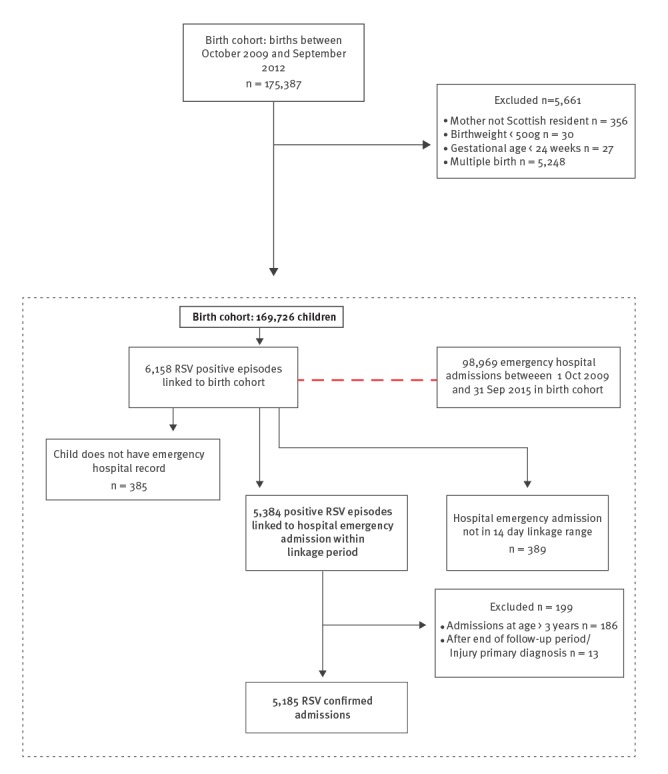
Flow chart of derivation of the final study cohort, respiratory syncytial virus hospital admissions birth cohort study, Scotland, 2009–2015 (n = 169,726)